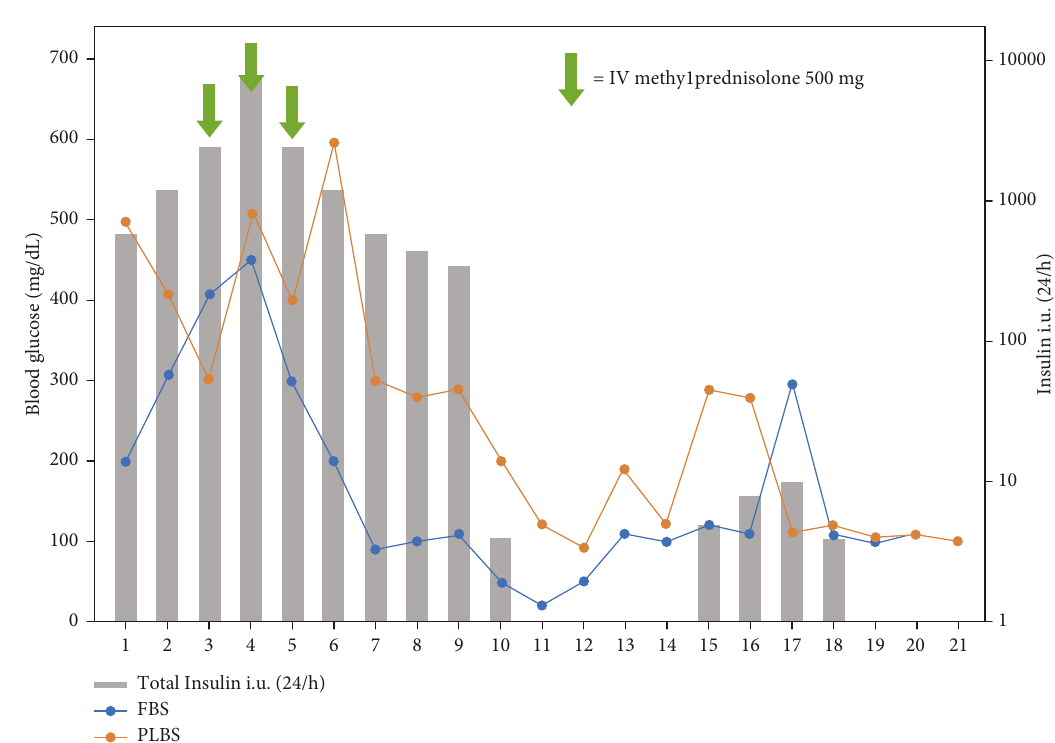
Figure 3: Blood glucose plot. Improvement after IV methylprednisolone pulse and oral prednisolone